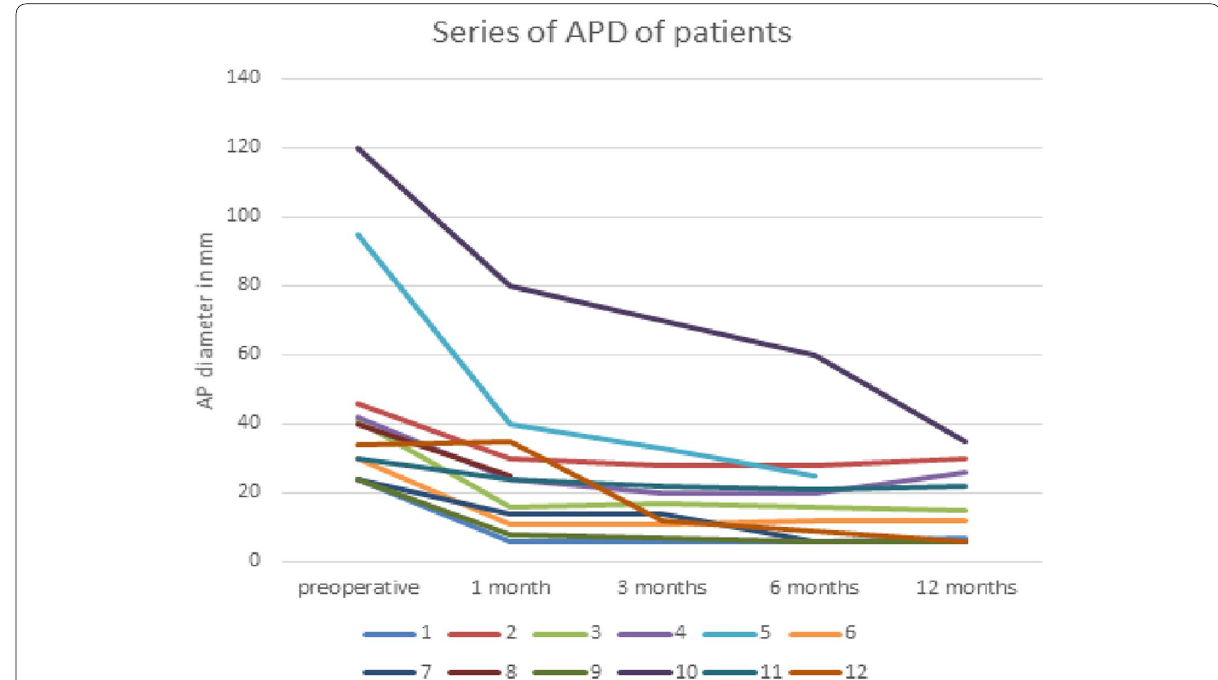
Fig. 5 A linear graph showing improvement in anteroposterior diameter of the renal pelvis in twelve cases (cases of isolated UPJO) after 12 months